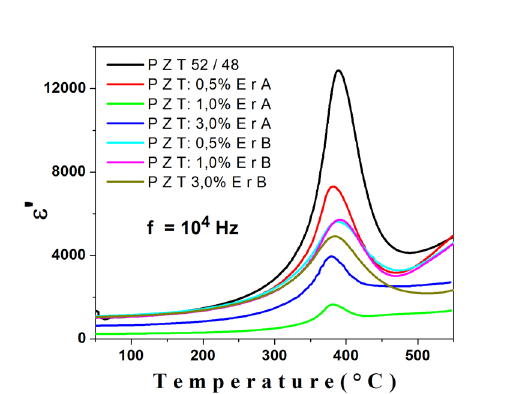
Figure 12. Dependence with the temperature of the real part of the permittivity for all compositions (f = 10 4 Hz).